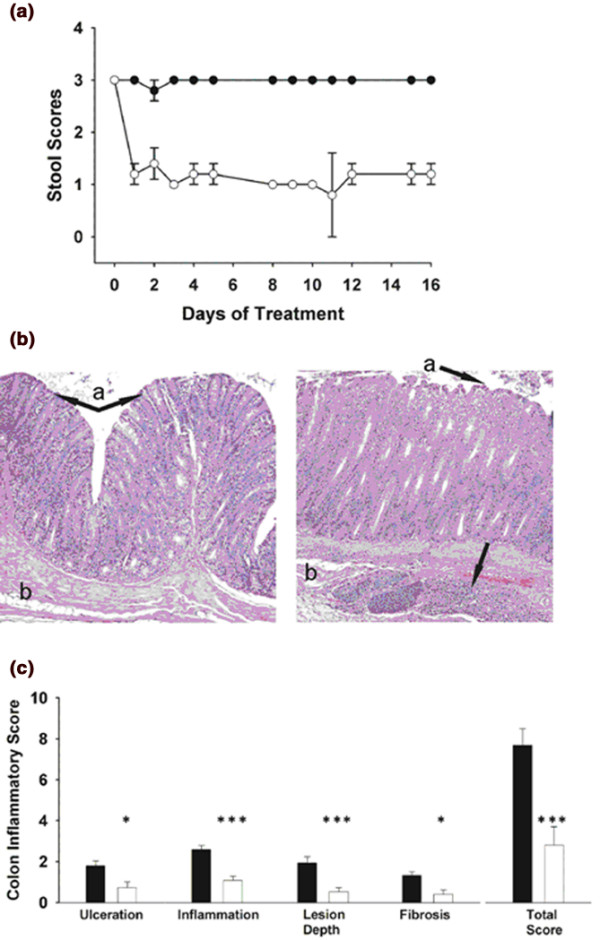
Effect of mAb C11C1 on HLA-B27 transgenic rats colonic inflammation. (a) Effects of monoclonal antibody (mAb) C11C1 on diarrhea in human leukocyte antigen B27 (HLA-B27) rats. Stool score was determined five times a week (normal stool = 1, soft stool = 2, watery stool = 3). mAb C11C1 (1.9 mg/kg) was administered three times a week for 16 days. The control group received murine isotype IgG1 (6 mg/kg) three times a week for 16 days. All stool scores are significantly different between the two groups for each corresponding day (P < 0.005) except for day 11 (P = 0.03). Data are shown as means ± SEM. Filled circles, IgG1-treated group; open circles, mAb C11C1-treated group. (b) Effects of mAb C11C1 on colonic mucosa in HLA-B27 rats. Photomicrographs of representative sections of colon from C11C1-treated (left) and IgG-treated (right) HLA-B27 transgenic rats. Note the extensive inflammatory cell infiltrates within the mucosa (a) and submucosa (b) with loss of villus formation on the mucosal surface indicated by the arrow (a) in the IgG group (right) compared with the C11C1 group (left). The branched arrow (left) points to the villus formation normally present in the colon (mAb C11C1-treated group). Hematoxylin and eosin stain; original magnification × 100. (c) Effects of mAb C11C1 on colonic inflammatory changes in HLA-B27 rats. mAb C11C1 decreased inflammatory changes in the colonic sections as evaluated by ulceration (P = 0.02), inflammation (P < 0.001), depth of lesion (P = 0.004), and degree of fibrosis replacement (P = 0.01) compared with IgG1 administration. Treatment with mAb C11C1 (open bars) significantly decreased the extent and intensity of the total colonic inflammatory score (P = 0.004). Data are shown as means ± SEM. *P < 0.05; ***P < 0.005.